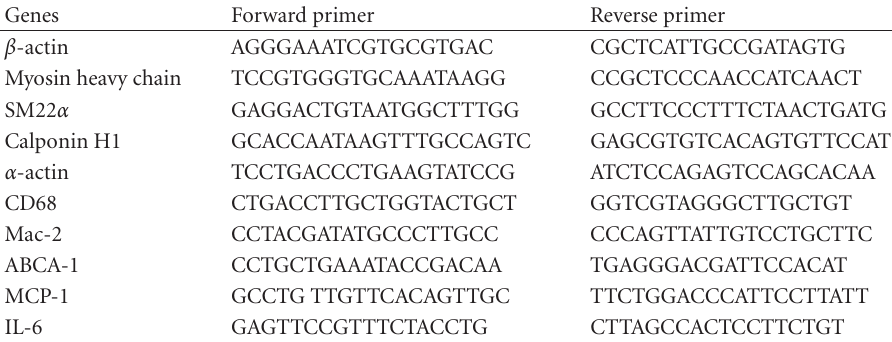
Table 1: Primer sequences for qRT-PCR, all sequences are from 5 (cid:2) to 3 (cid:2) .